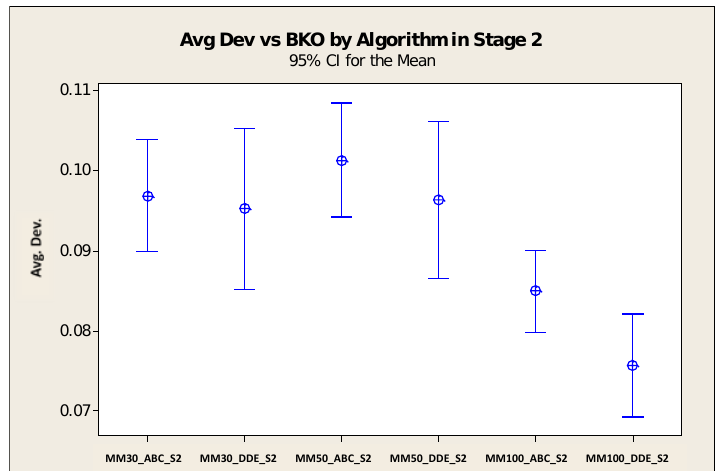
Figure 4. Avg dev vs. BKO CI for each algorithm in Stage 2 (MRCPSP/max).